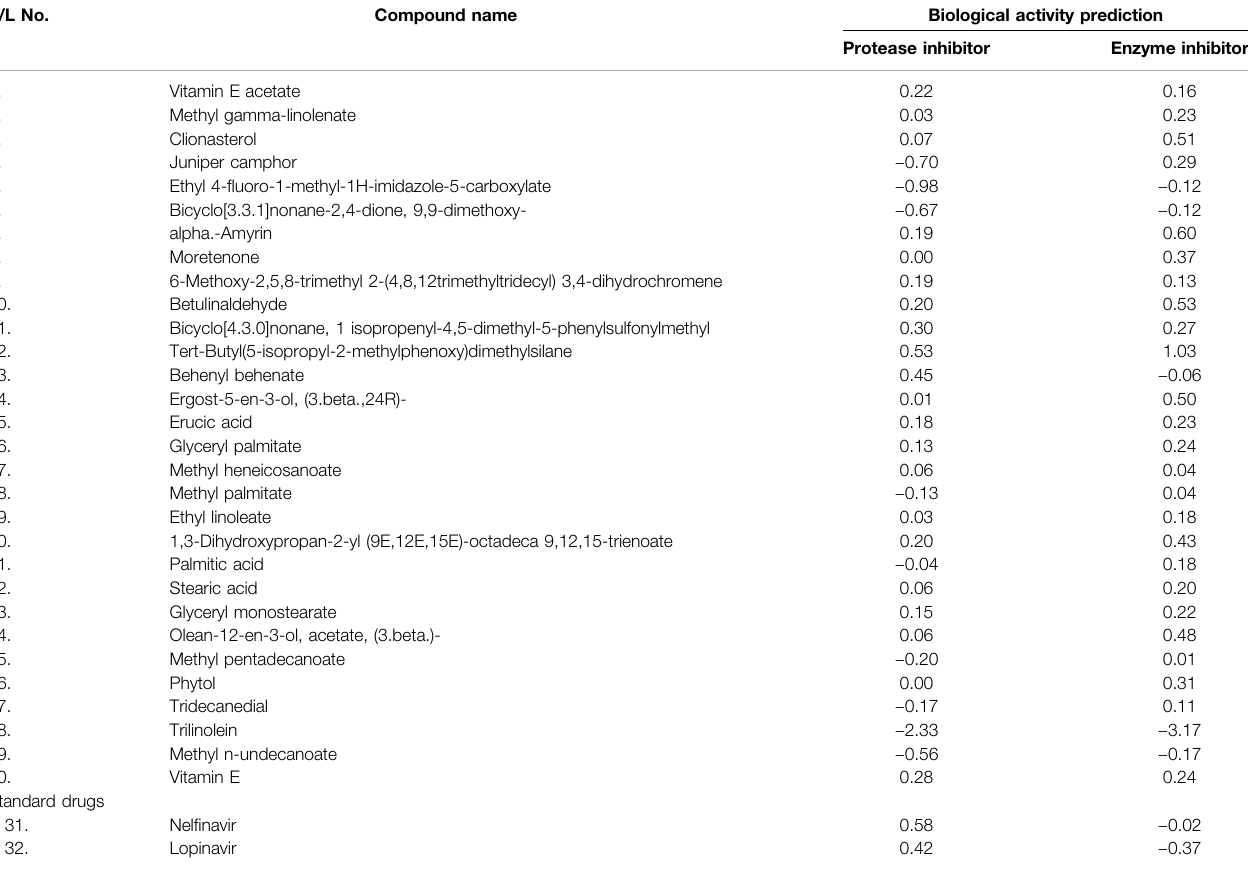
TABLE 4 | Biological activity parameter of the selected bioactive compounds. S/L